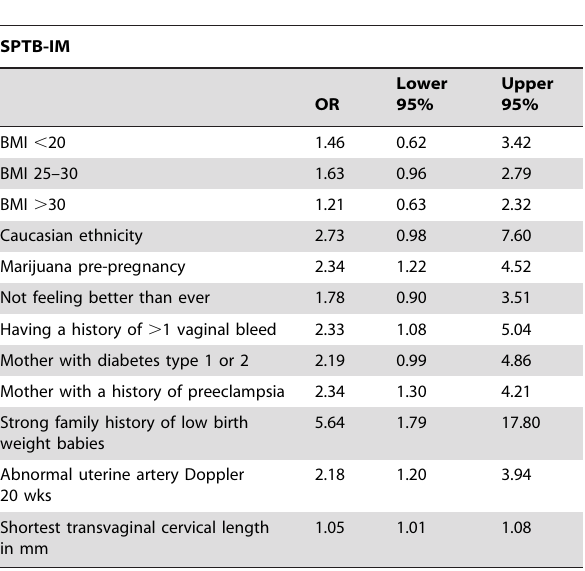
Table 2. Clinical risk factors at 15 weeks, and ultrasound scan variables at 20 weeks in logistic regression model for SPTB-IM.